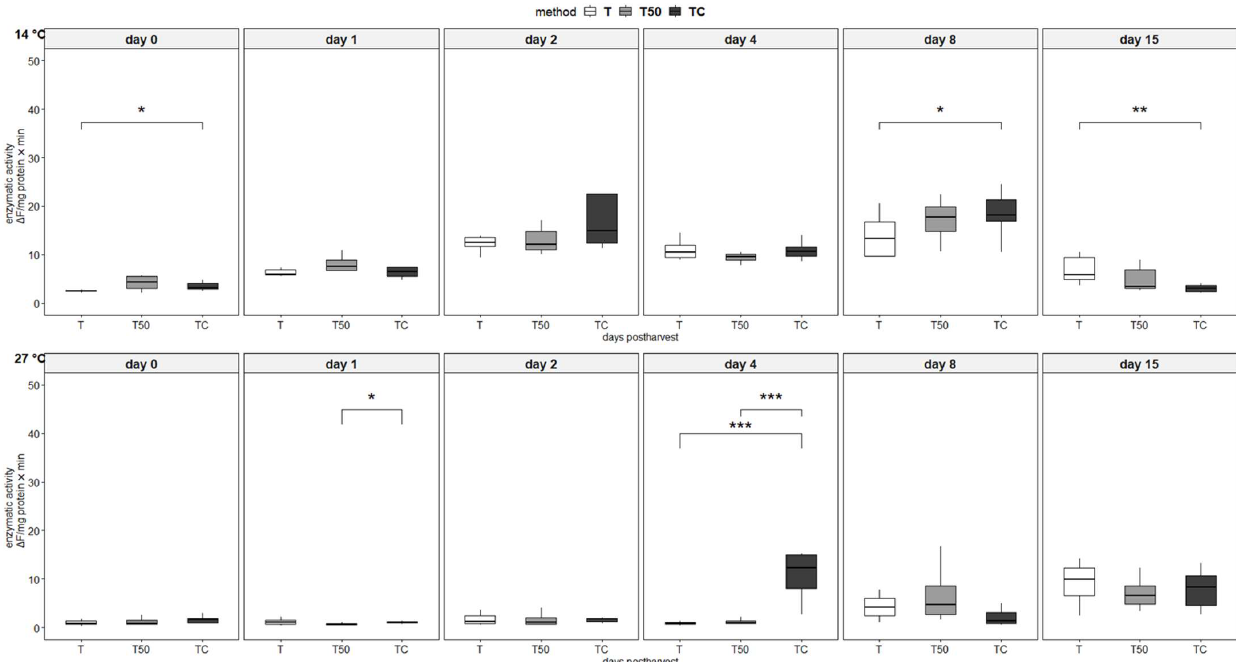
Figure 7. Cathepsin L activity in all tested slaughter and storage conditions. T: control group, slaughter and storage in ice flakes; T50: slaughter and storage in 1:1 slurry ice to ice flakes; TC: slaughter in slurry ice, storage in ice flakes. Enzymatic activity was expressed as fluorescence unit (FLU) change per minute per mg protein (ΔF). Superscripts: statistically significant differences between treatments on each sampling day ((***: p < 0.001, ** p < 0.01, *: p < 0.05).